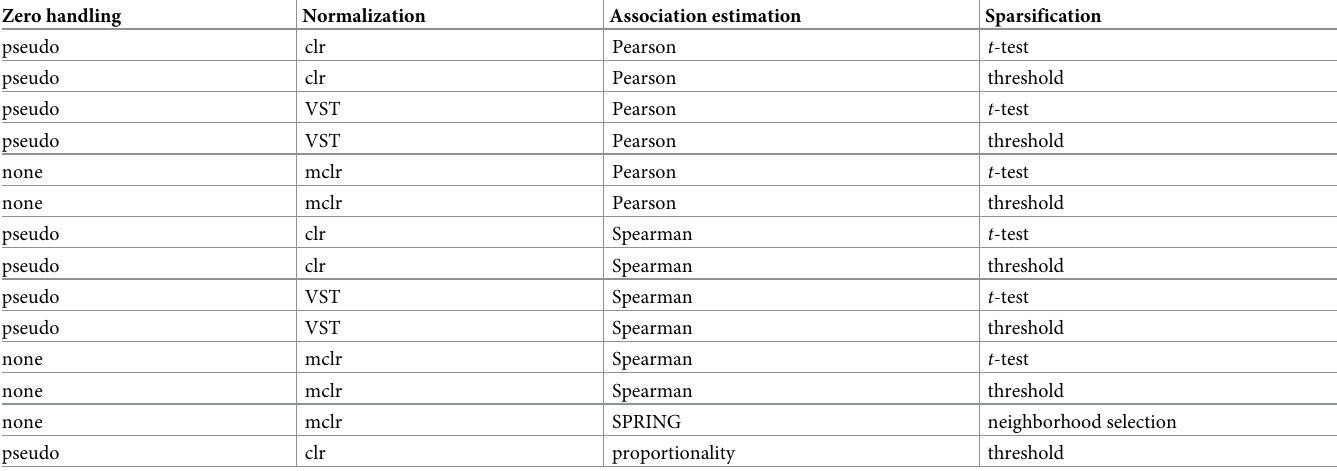
Table 6. Method combinations for generating weighted microbial association networks. The networks were used as input for fast greedy modularity optimization, Lou- vain community detection, and manta. Zero handling